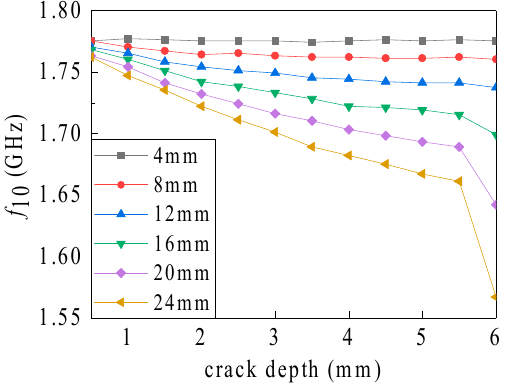
Table 3. Identification sensitivity of the crack depth.